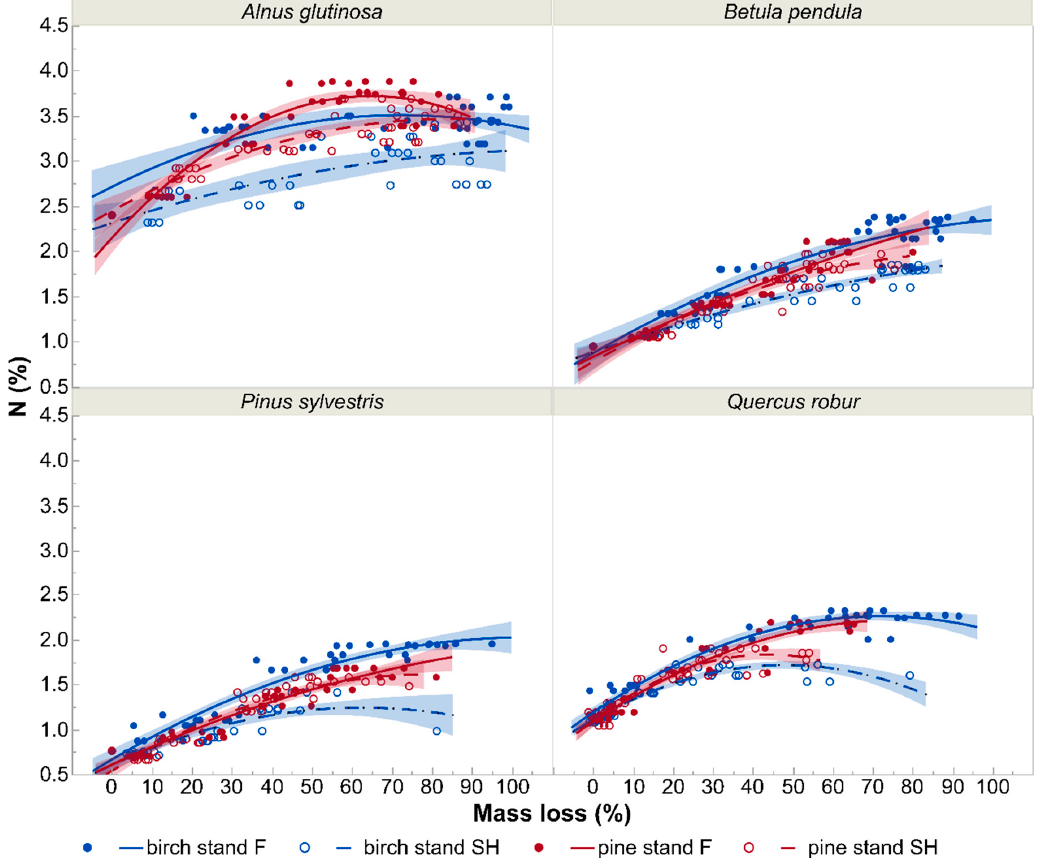
Figure 5. Effects of decomposition level on nitrogen concentration (N; %) of particular tree species leaf litter in birch and pine stands growing in two different site types—post-mining external spoil heap (SH) or forest sites (F). Visualization is based on quadratic models with 95% confidence intervals for the predicted values. The markers on the graph show mean values of nitrogen concentrations of particular tree species at particular decomposition stages.